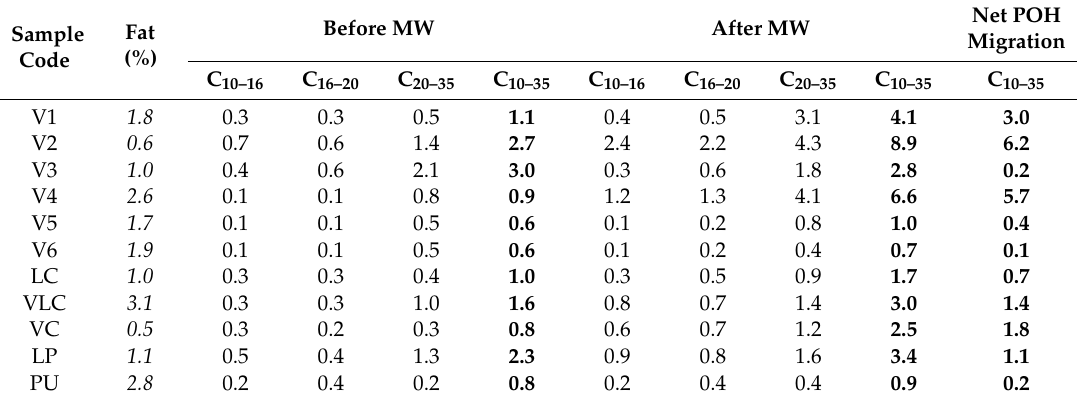
Table 2. POH / mineral oil saturated hydrocarbons (MOSH) content (mg / kg) of vegetable soup samples before and after microwave heating and net